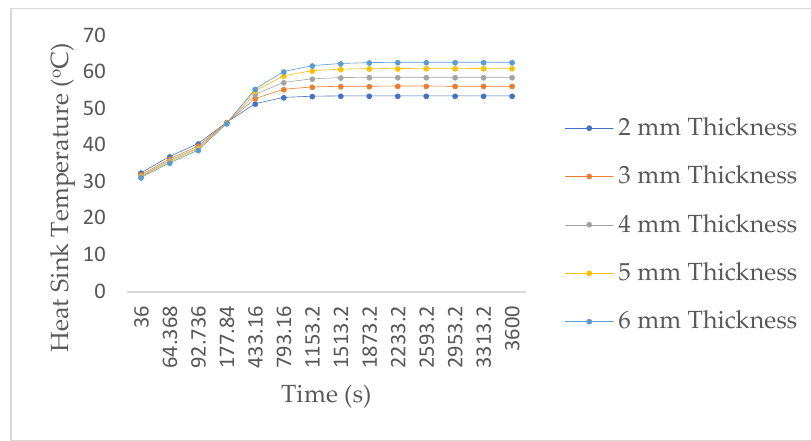
Figure 5. Temperature plot of heat sink at 9.7 W.